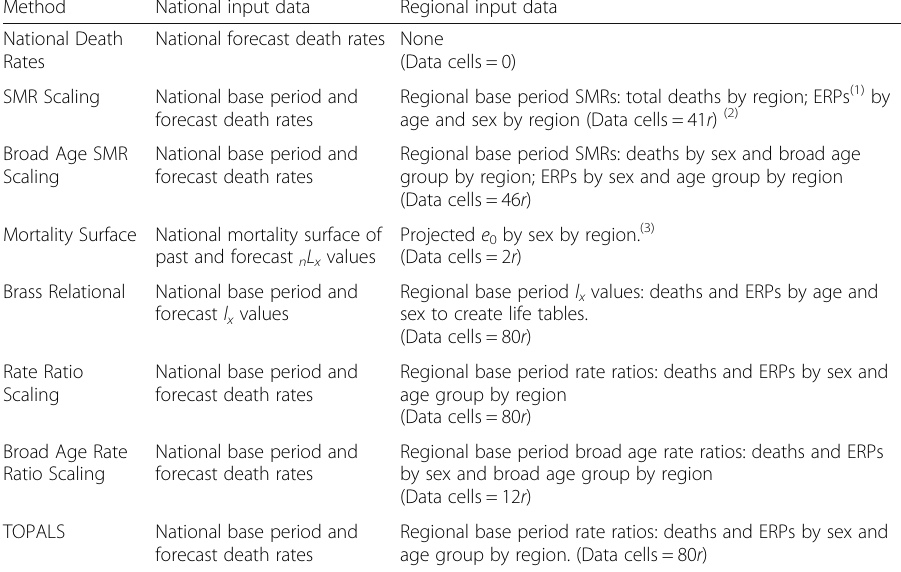
Table 2 Input data requirements of the eight regional mortality forecasting methods